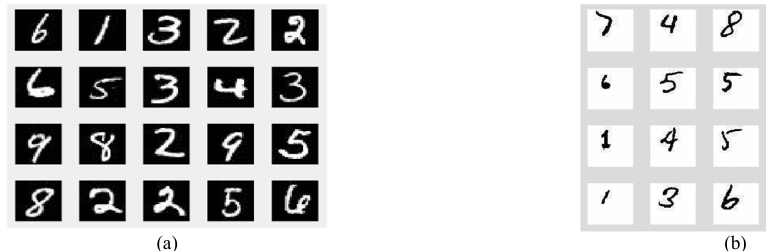
Fig. 4 Exhibition of a part of experimental (a) MNIST dataset (b) Handwritten digit dataset or Dataset-2 TABLE 1 D ATA A RRANGEMENT OF B OTH D ATASETS F OR T RAINING AND V ALIDATION FOR CNN ARCHITECTURES Image